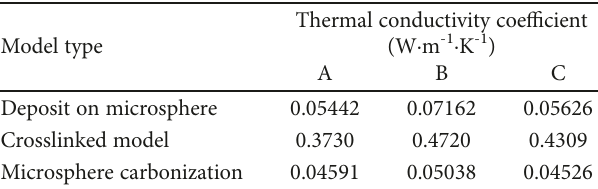
Figure 29: Pro fi le image of the heat fl ow vector of the microsphere carbonization model. Table 3: Thermal conductivity coe ffi cient of microsphere